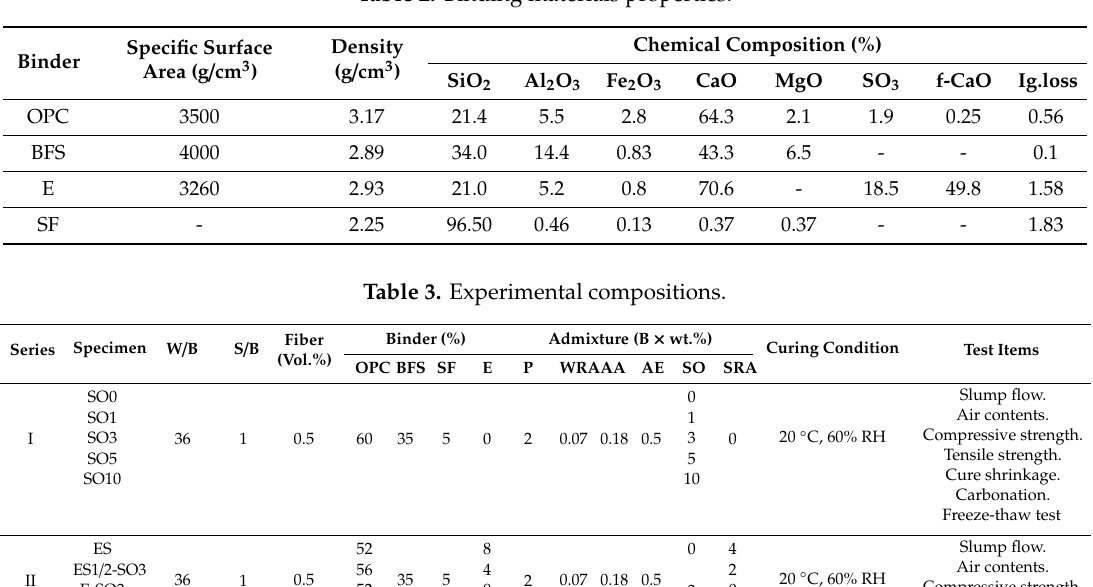
Table 2. Binding materials properties.